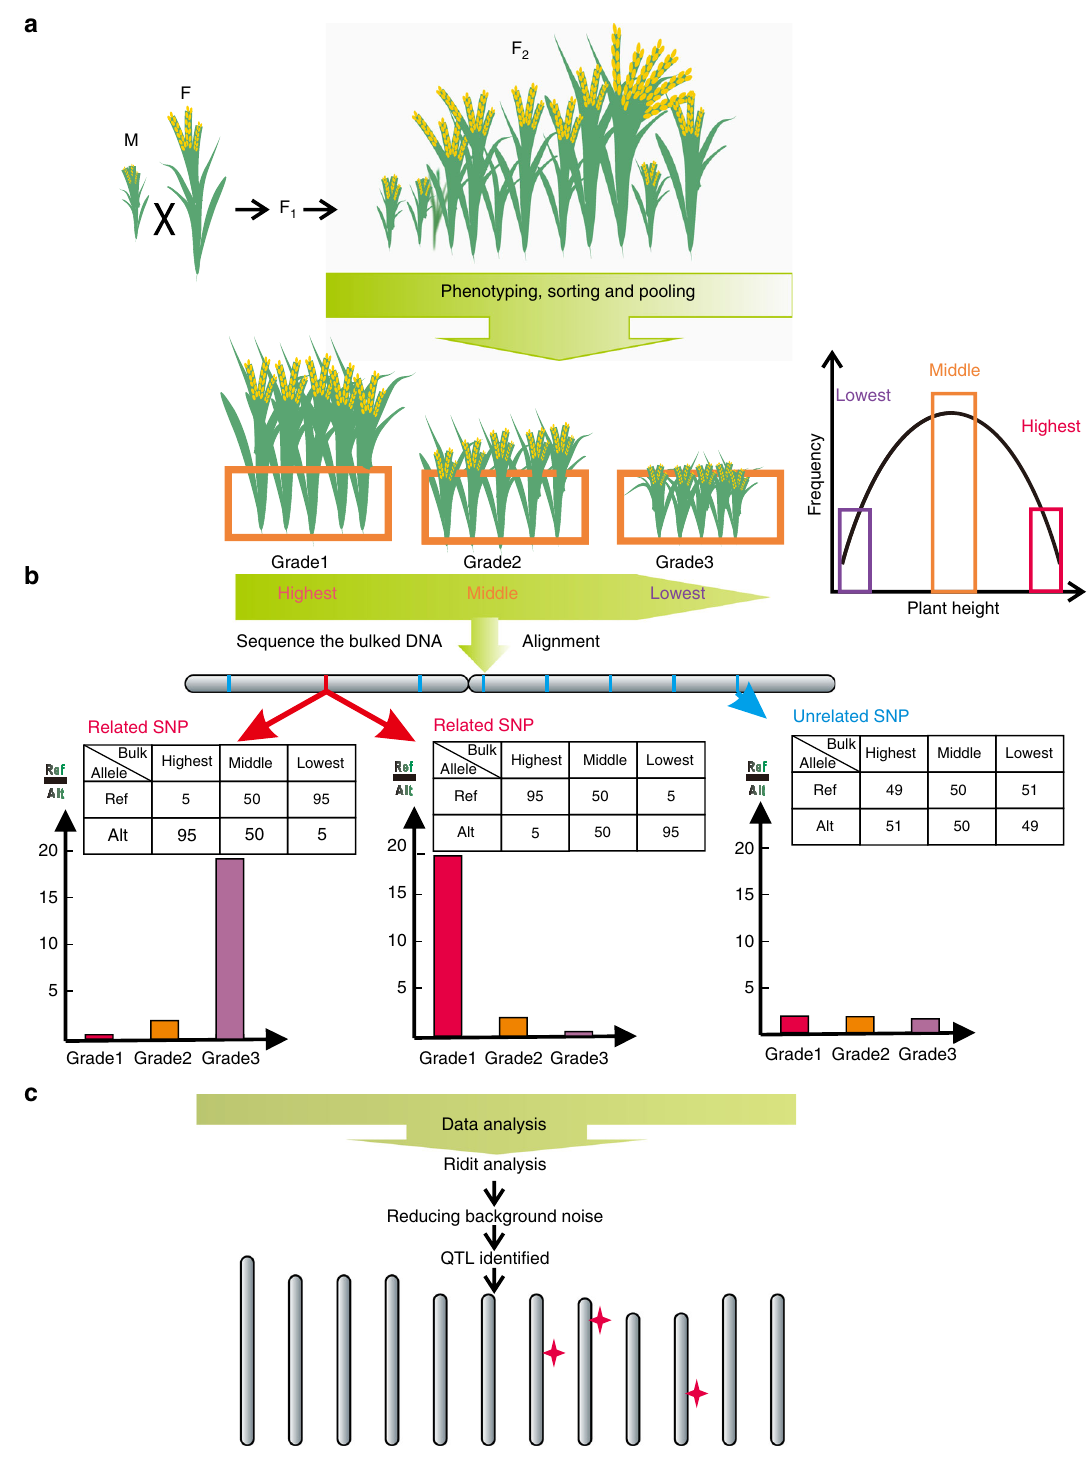
Fig. 1 The procedure of the GPS method. a F 2 populations were generated by crossing two parent lines with distinct background and showed vastly different in plant height, followed by the self-pollination of F 1 generation. Through the observation of plant height, F 2 populations were classi fi ed from the highest to lowest bulk according to their frequency distribution. The letters M and F indicated the male parents and female parents, respectively. b The sequence reads of each bulk were aligned against the reference genome sequence to estimate allelic frequencies. We assumed that the depth at each SNP was 100×. If a variance was not related to the phenotype, it would present 50% reference reads and 50% alternate reads in all three bulks (right), whereas the related SNP would have great distinction of the ratio of reference reads to alternate reads among three bulks (left and middle). c Data analysis included Ridit analysis and reducing background noise approach. Several associated genetic intervals were mapped and indicated as red four-pointed